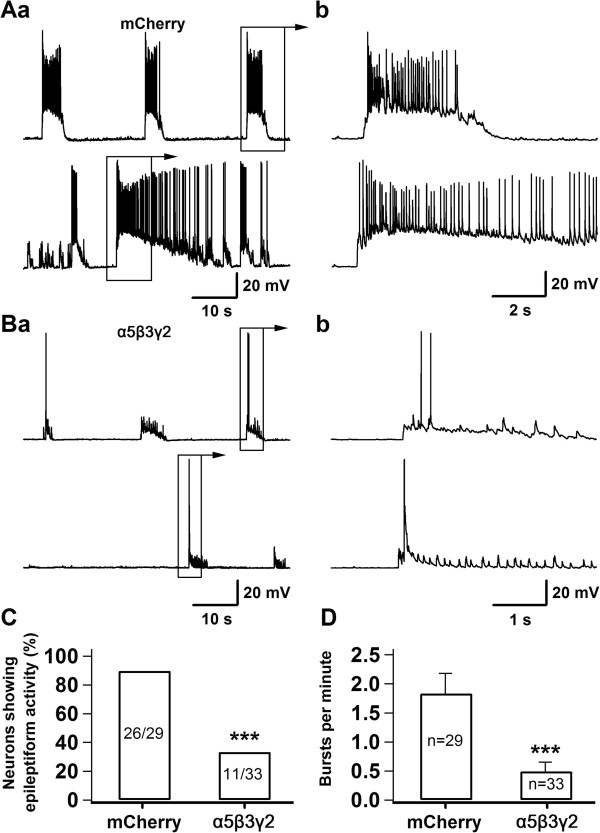
Inhibition of epileptiform activity in cultured hippocampal neurons overexpressing α5β3γ2 receptors. A, Typical traces from two hippocampal neurons showing the epileptiform burst activity after chronic CTZ treatment (5 μΜ, 24 h). Panel b shows the expanded view of a single epileptiform burst from panel a. Epileptiform burst is characterized by a train of action potentials on a large depolarization shift. B, Representative traces showing the lack of epileptiform bursts in two hippocampal neurons transfected with the α5β3γ2 receptors. C, Bar graphs illustrating that overexpression of α5β3γ2 receptors significantly reduced the percentage of neurons showing epileptiform activity after chronic CTZ treatment (mCherry, ~90%, n = 29; α5β3γ2, ~33%, n = 33; ***, p < 0.001). D, Neurons transfected with α5β3γ2 receptors showing lower burst frequency (0.49 ± 0.16 per min, n = 33), compared to mCherry controls after CTZ treatment (1.83 ± 0.35 per min, n = 29; ***, p < 0.001).